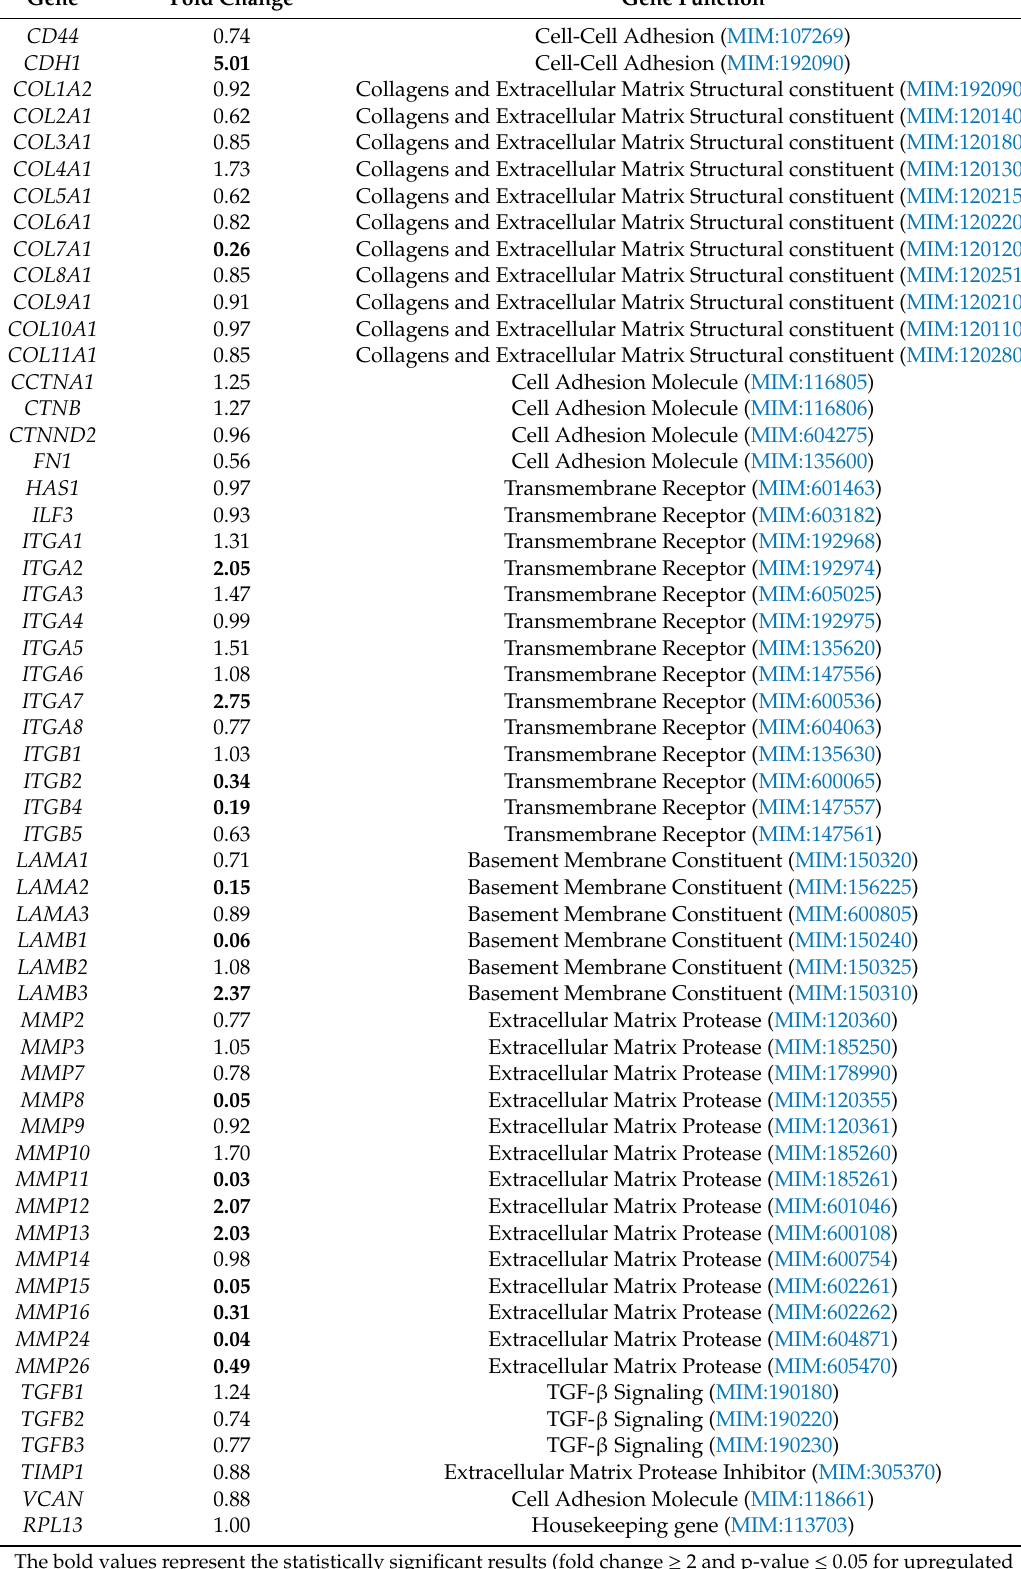
Table 2. Gene expression profile of 57 genes belonging to the “Extracellular Matrix and Adhesion Molecules” pathway analyzed using real-time PCR after 24 h of treatment with cyclosporine [34]. Gene